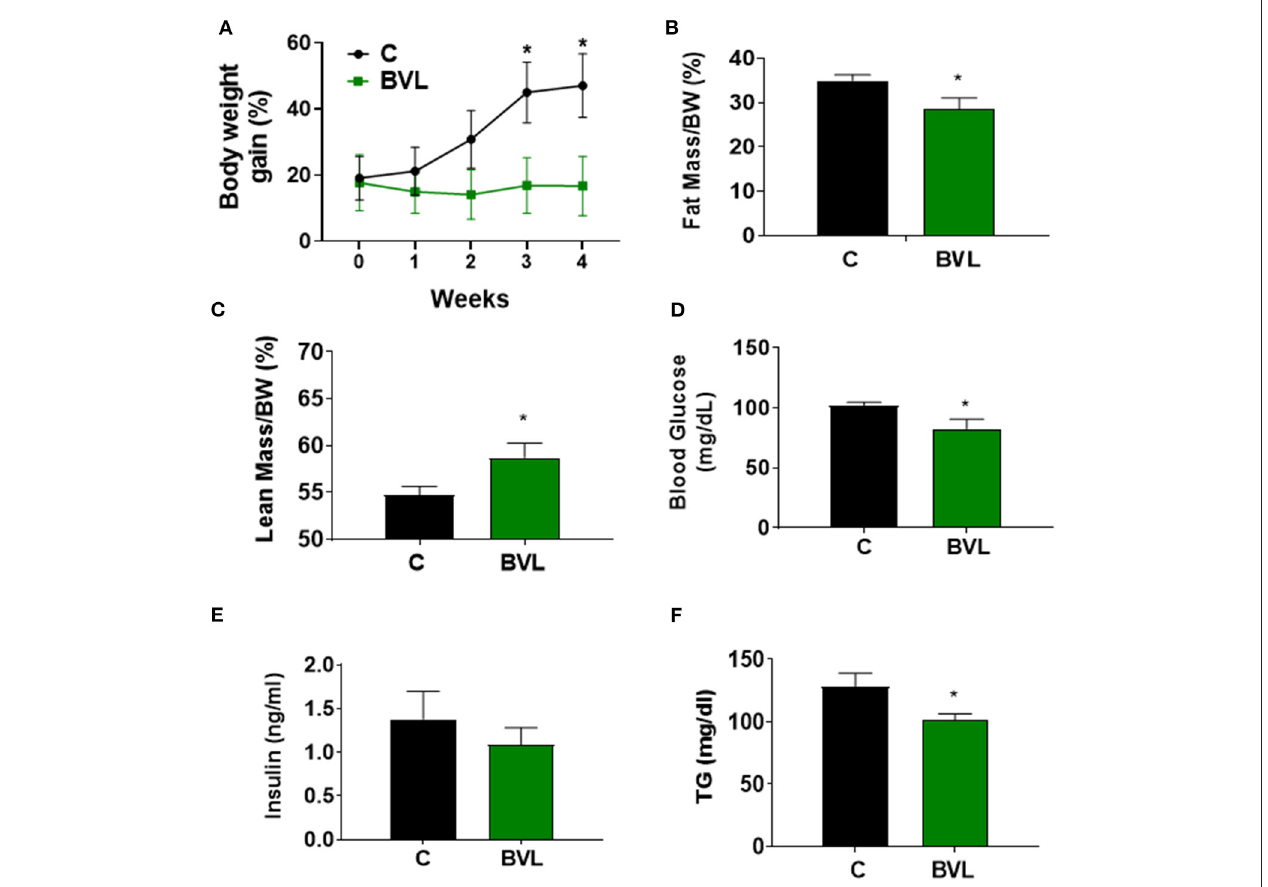
FIGURE 1 | BVL reduces body weight gain in HFD-induced obese mice. After a 3-week HFD feeding, animals were randomly assigned to two groups, HFD and HFD + BVL, which were fed HFD in the absence and presence of BVL for another 4 weeks. (A) The changes of body weight gain. The result was shown by combing two independent experiments. w/wo: with/without. Body composition was measured and the percentage of fat mass (B) as well as lean mass (C) was shown. Fasting blood glucose (D) , insulin levels (E) , and plasma TG levels (F) were compared between groups. The values were presented using mean ± SEM ( n = 4–6). * p <